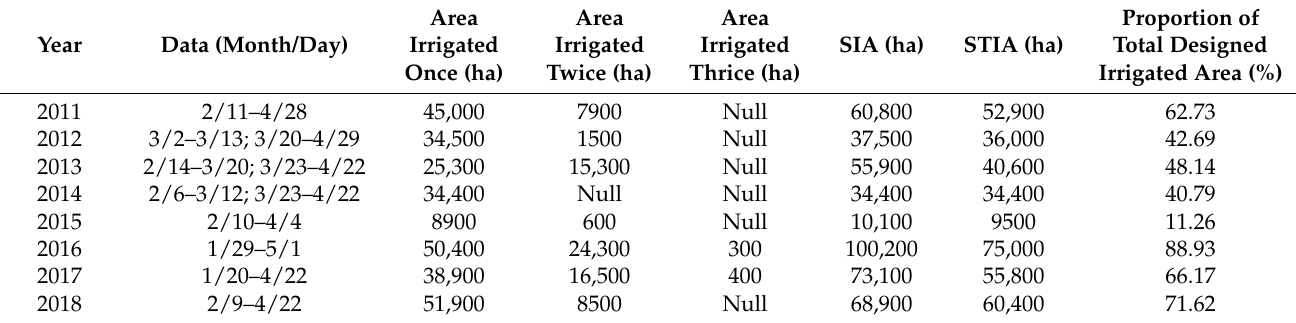
Table 2. Statistical table of SIA and STIA in the study area during spring irrigation from 2011 to 2018.